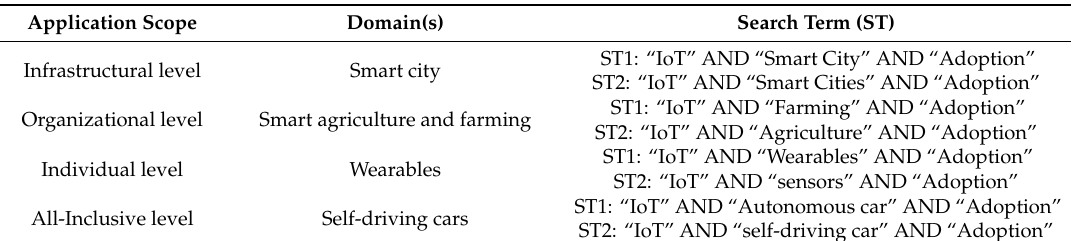
Table 1. Overview of the search